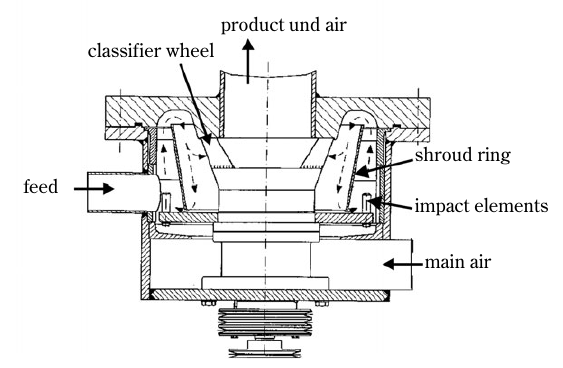
Fig. 6 Air classifier mill